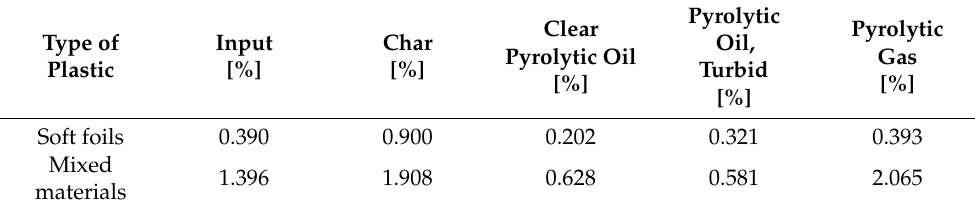
Table 5. Nitrogen content of substrates and